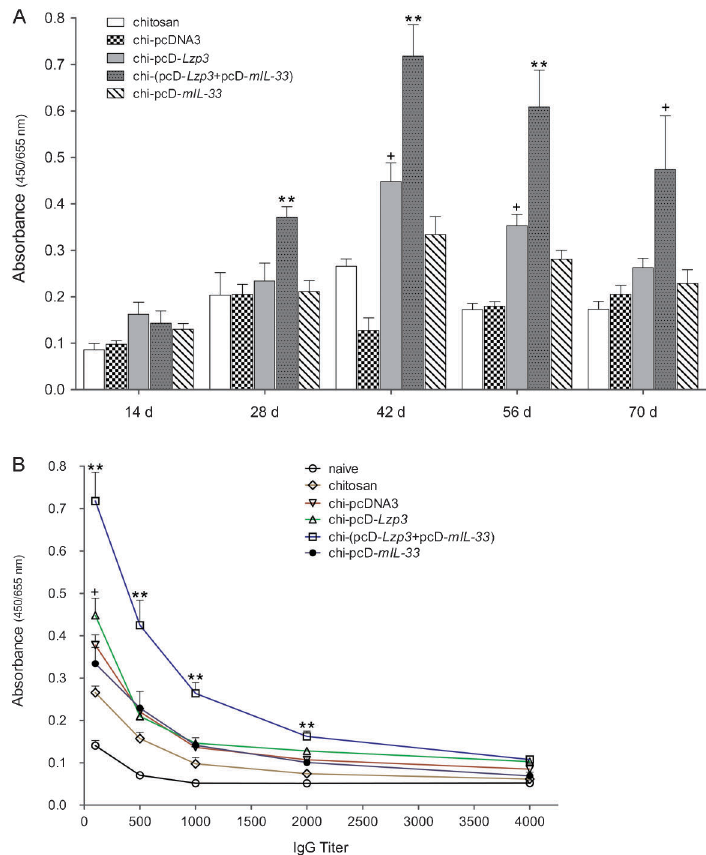
Figure 4. Serum anti-LZP3 IgG of ICR mice immunized intranasally with different chitosan- DNA nanoparticles. Serum samples were col- lected from mice (n=12/group) immunized with different nanoparticles on days (d) 14, 28, 42, 56, and 70 after the 1st immunization. A , Anti-LZP3 IgG levels of serum (diluted at 1:100) were detected by ELISA on days 14, 28, 42, 56, and 70. + P , 0.05, compared to the control groups immunized with chitosan, chi-pcDNA3 and chi- pcD- mIL-33 ; **P , 0.01, chi-(pcD- Lzp3 +pcD- mIL-33 ) group compared to the chi-pcD- Lzp3 group and the control groups (one-way ANOVA). B , Serum anti-LZP3 IgG levels (diluted from 1:100 to 1:4000) were assessed by ELISA on day 42 after the 1st immunization. + P , 0.05, chi- pcD- Lzp3 group compared to the control groups; **P , 0.01, chi-(pcD- Lzp3 +pcD- mIL-33 ) group